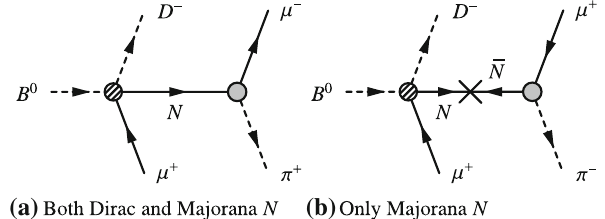
Fig. 3 Meson-level Feynman diagrams contributing to the decays B 0 → D − μ + μ ∓ π ± . The sterile neutrino is produced at the first ver- tex and decays at the second vertex, which is at an observable distance away from the first vertex. The circular blobs connote the contributions from the corresponding hadronic form factors and decay constants. The cross in the Majorana scenario denotes the helicity flip involved in the decay